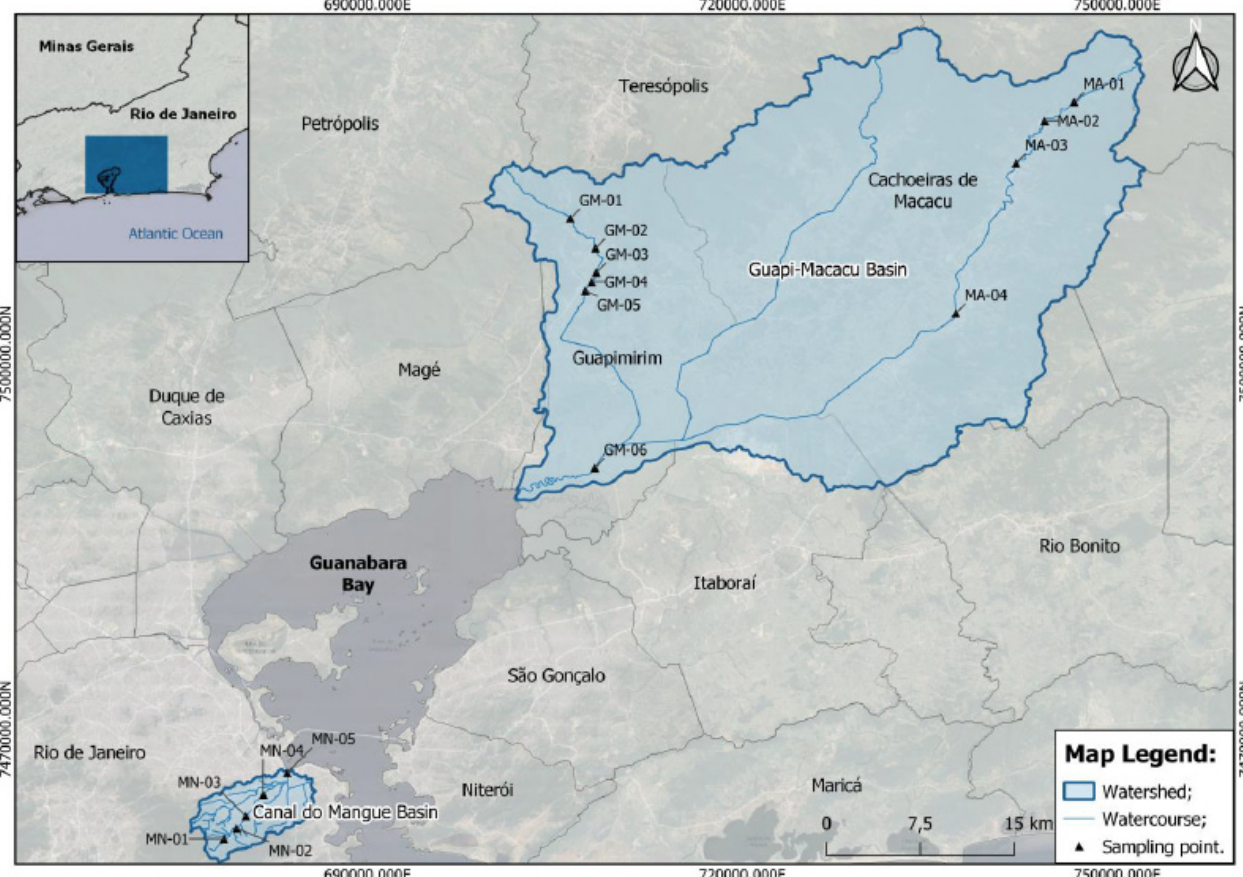
Figure 1. Sampling site in the watershed around Guanabara Bay in the State of Rio de Janeiro State, Brazil.